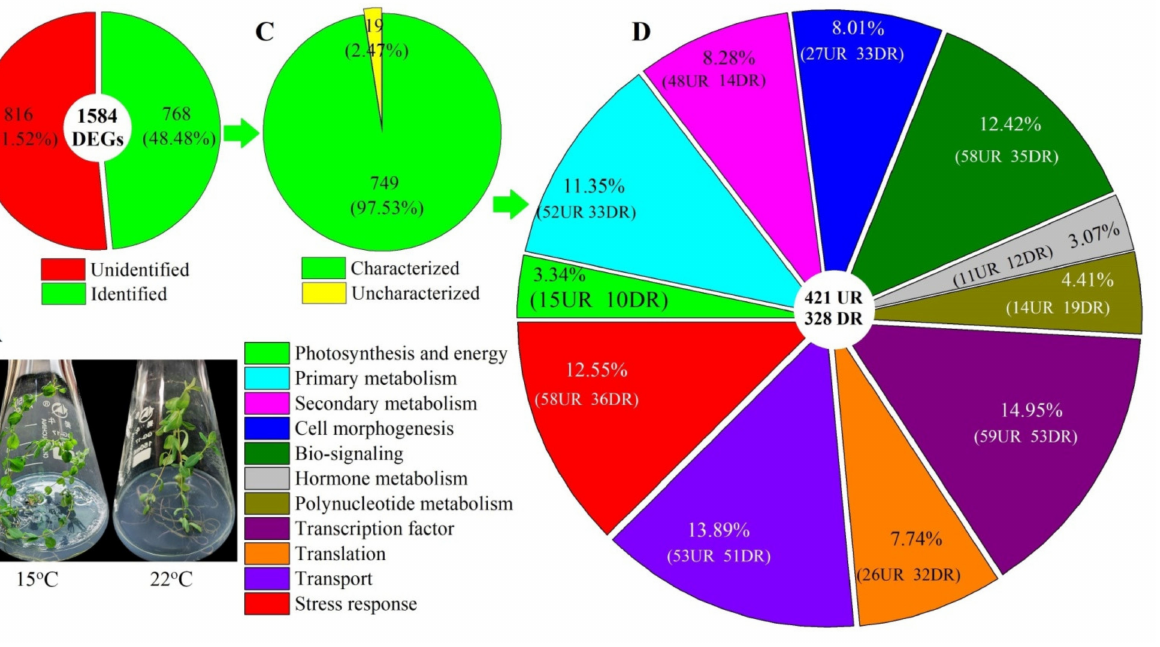
Figure 4. Distribution and classification of differentially expressed genes (DEGs) at 15 versus 22 ◦ C. UR, upregulated and DR, downregulated. Image ( A ) represents the phenotype at 15 and 22 ◦ C, image ( B ) represents the classification of unidentified and identified genes, image ( C ) represents the classification of uncharacterized and characterized genes, and image ( D ) represents the classification of the functional genes.